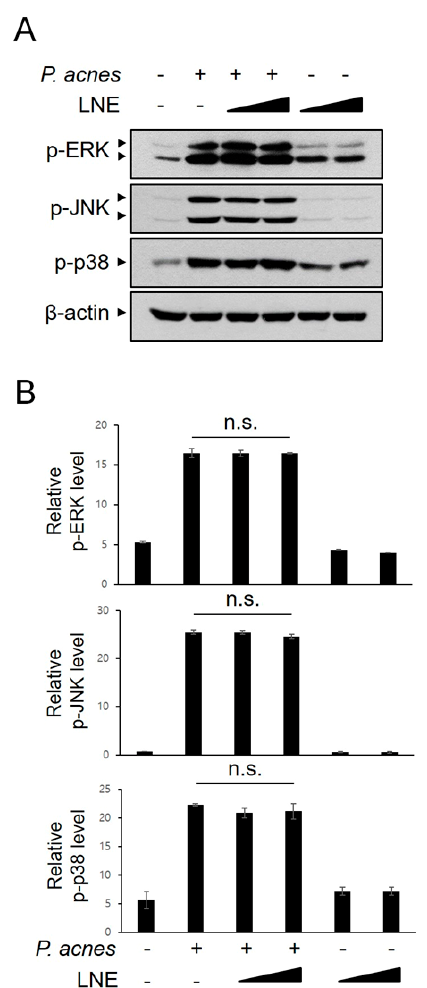
Figure 5. LNE has no effect on the P. acnes -induced MAPK signaling pathways. BMMs were treated with LNE (25 and 50 µ g / mL) for 30 min before P. acnes stimulation (1 × 10 7 CFU) for 6 h. Phosphorylated MAPKs and GAPDH expression were detected by Western blot ( A ) and quantified ( B ).